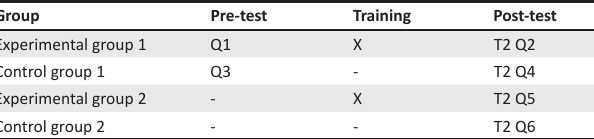
TABLE 1: Diagrammatic representation of the Solomon four research design. Group Pre-test